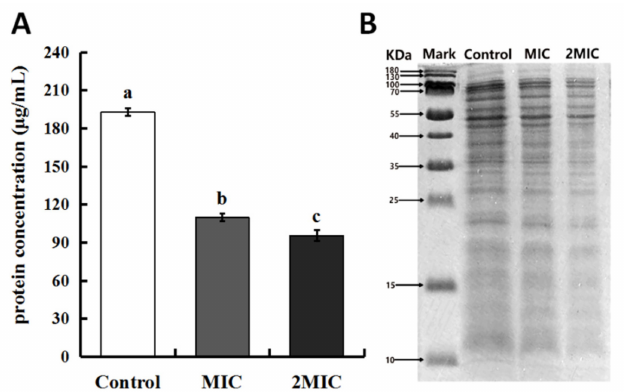
Figure 4. The e ff ect of MEO on the protein of S. aureus. ( A ) The e ff ect of MEO on the intracellular protein of S. aureus ; ( B ) SDS-PAGE profile of intracellular proteins of S. aureus cells treated with MEO. Di ff erence letters means statistical di ff